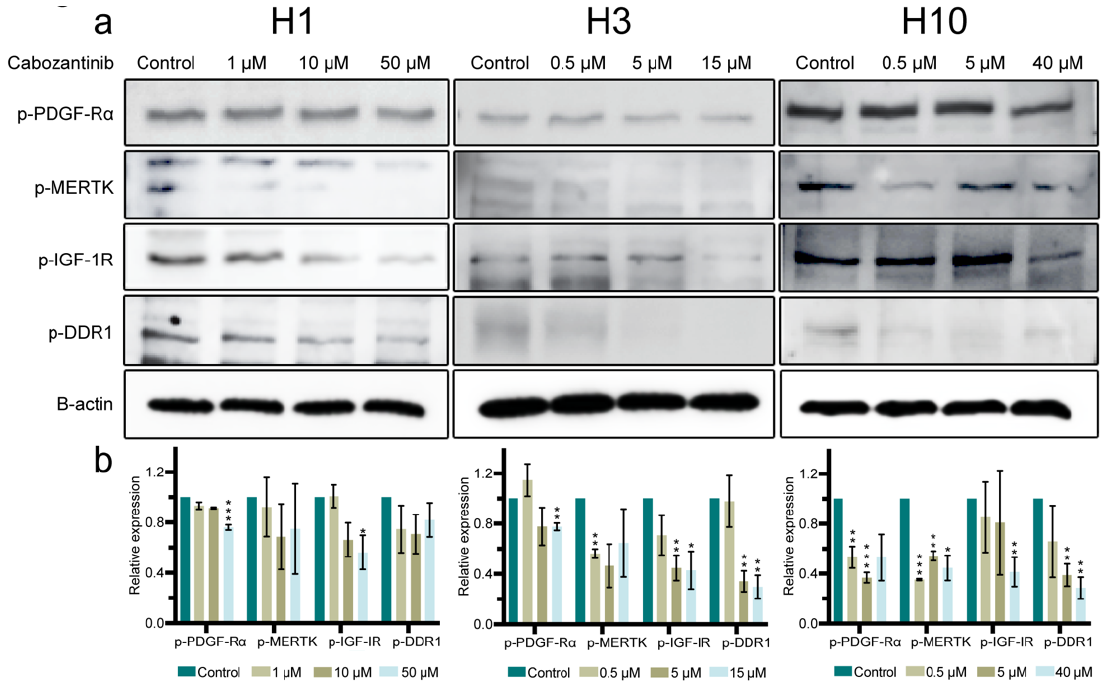
Figure 6. Cabozantinib downregulates the expression of p-PDGF-R α , p-IGF-1R, p-MERTK and p-DDR1 in MBM cell lines. ( a ) Western blots showing selected p-RTKs in H1, H3 and H10 cells either untreated (control) or treated with 1 µ M, 10 µ M or 50 µ M (H1), 0.5 µ M, 5 µ M or 15 µ M (H3) and 0.5 µ M, 5 µ M or 40 µ M (H10) cabozantinib for 72 h, respectively. ( b ) Quantification of the target proteins detected in the Western blots. The expression levels of the target proteins were normalized against b-actin and compared relatively as a ratio to the control for each specific protein. The Western blot experiments were performed in triplicate. Full-length blots are presented in Supplementary Figure S5a. *: p < 0.05; **: p < 0.01; ***: p < 0.001.